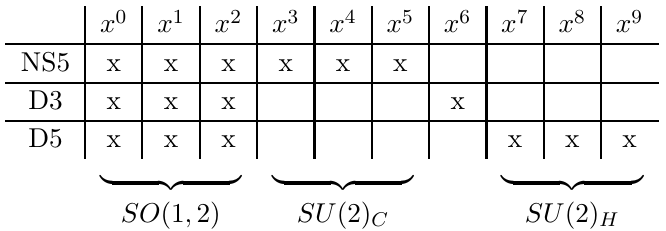
Table 1 . The ‘x’ mark the spacetime directions spanned by the various branes. The groups SO (1 , 2), SU (2) H and SU (2) C can be